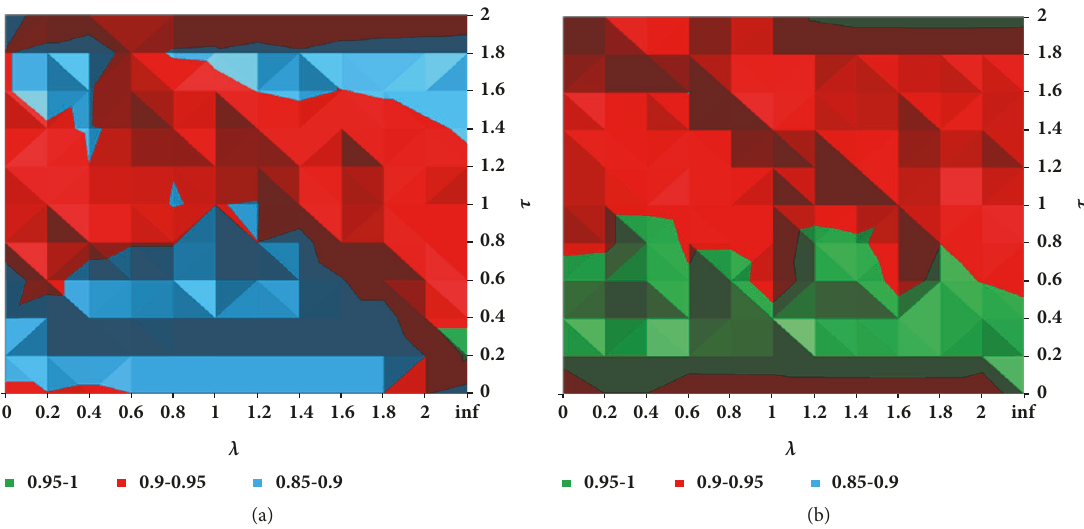
Figure 10: Distribution of removing load under different parametric combinations on the French grid. (a)IM and